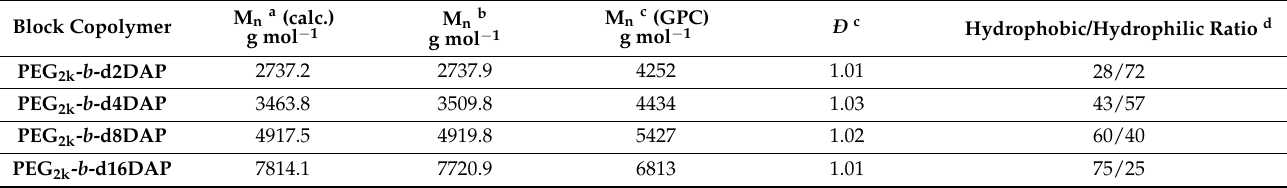
Table 1. Molar mass, dispersity, and hydrophobic/hydrophilic ratio of the synthesized LDBCs. Block